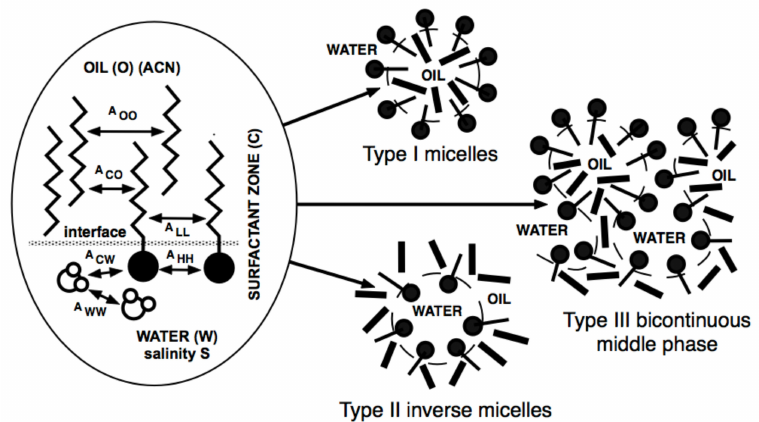
Figure 2. Interactions of the surfactant molecule adsorbed at the oil–water limit with neighboring water and oil molecules found in swollen micelles (Type I) or inverse micelles (Type II), as well as in middle phase lamellae or other complex bicontinuous structure (Type